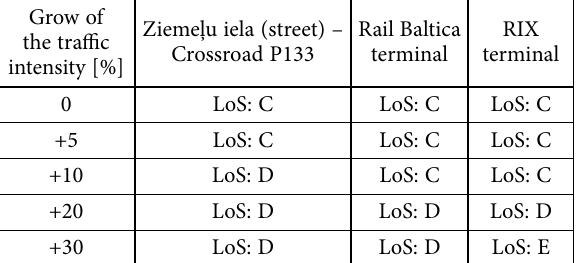
Table 4. Sensitivity analysis (scenario